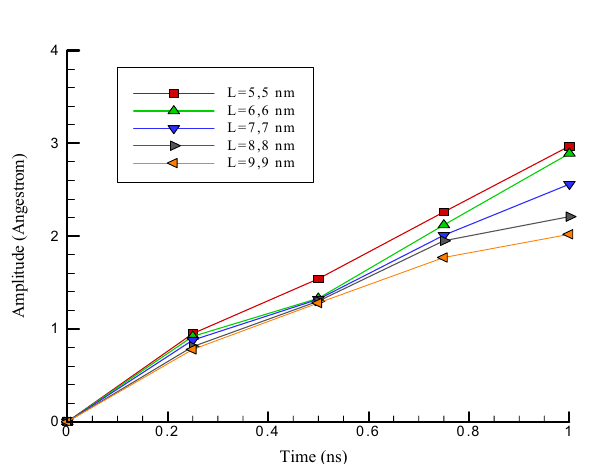
Table 3. Highest values of, interaction energy, amplitude and oscillation frequency of carbon nanotubes with a length of 5 nm versus chirality of carbon nanotubes in the last time step of molecular dynamics simulation.